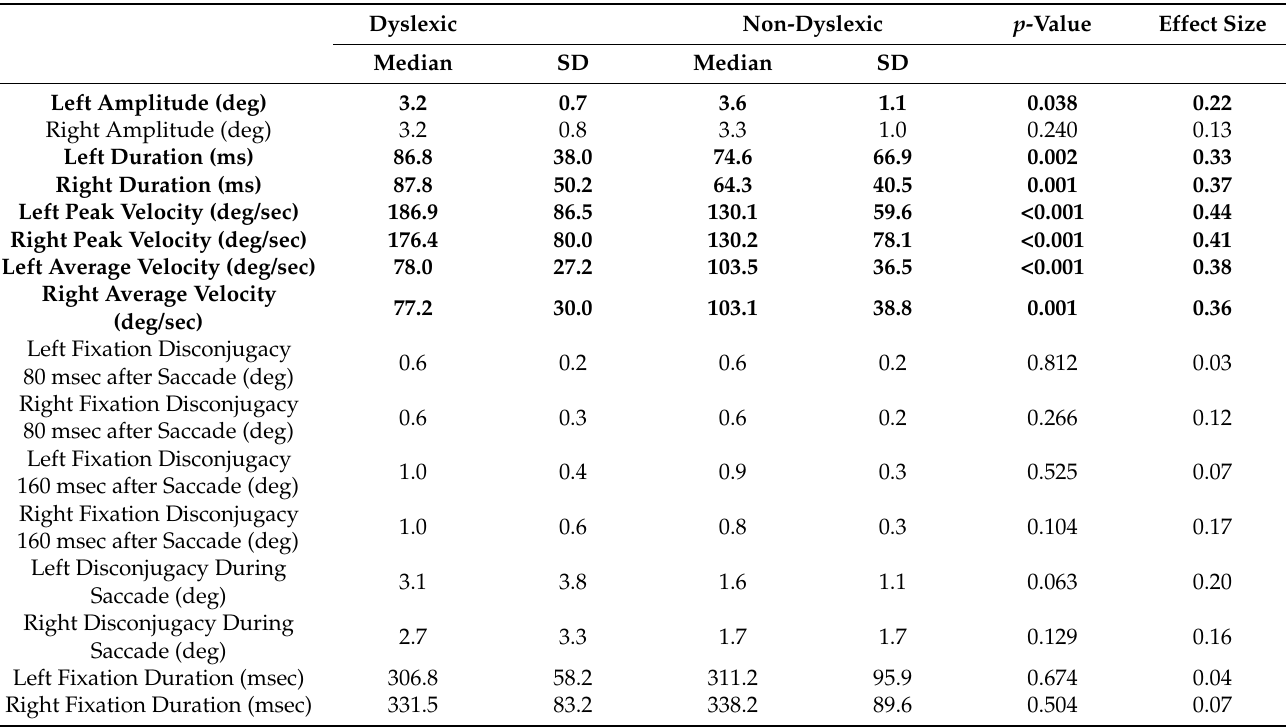
Eye movements while viewing Painting 2.